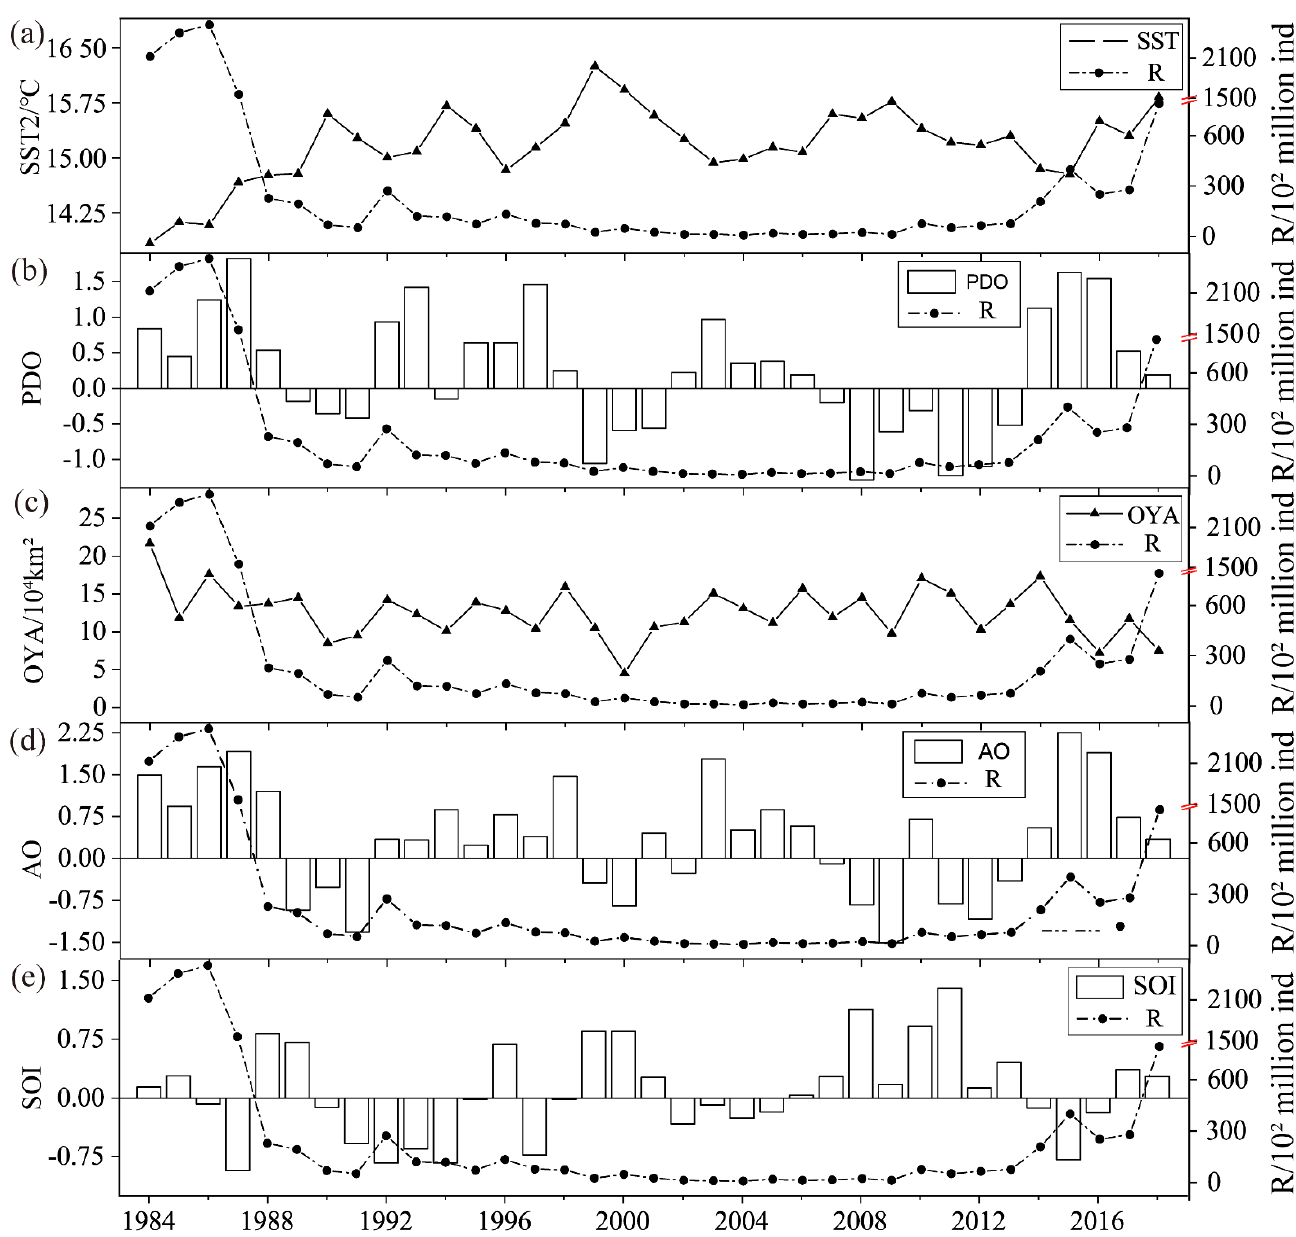
Figure 3. Time series plots of trends in environmental factors and recruitment during 1984–2018. ( a ) Trend of SST and R time series; ( b ) Trend of PDO and R time series; ( c ) Trend of OYA and R time series; ( d ) Trend of AO and R time series; ( e ) Trend of SOI and R time series.